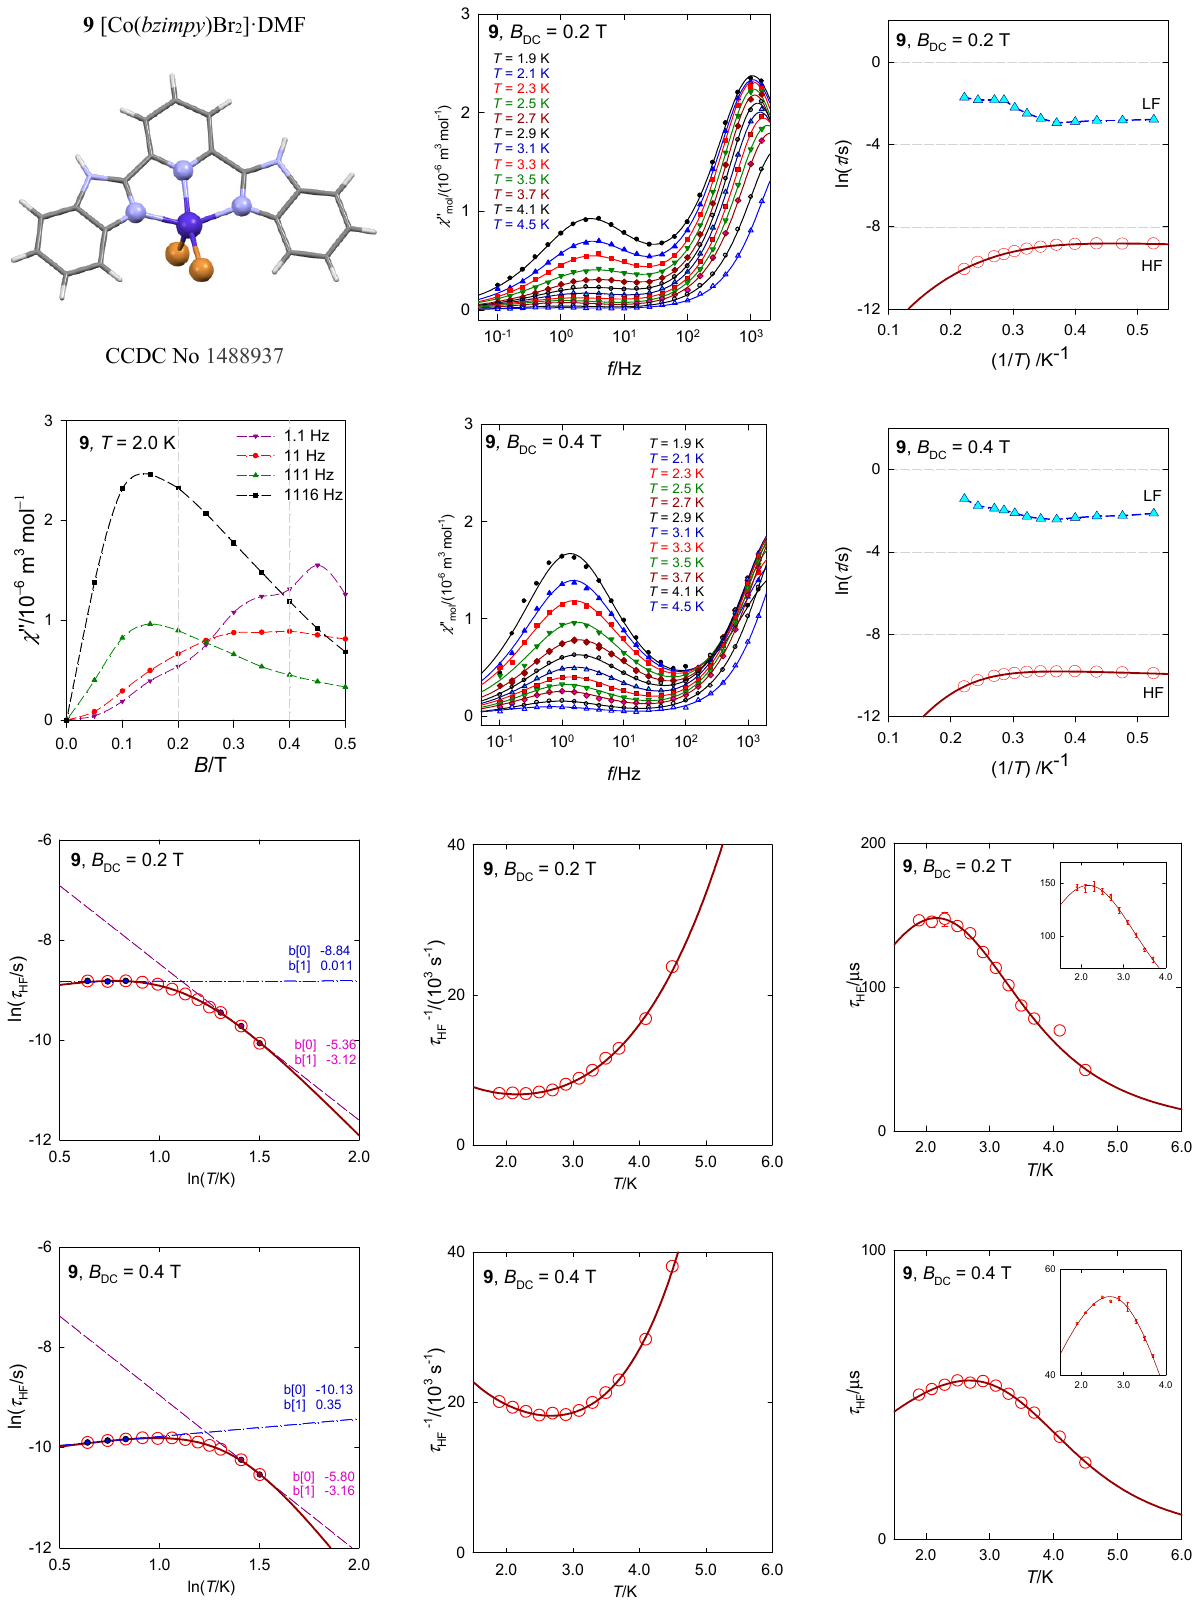
Figure 17. AC susceptibility data for 9 . Full lines—fitted. Data adapted from ref. [40]. 2017, Wiley-VCH.